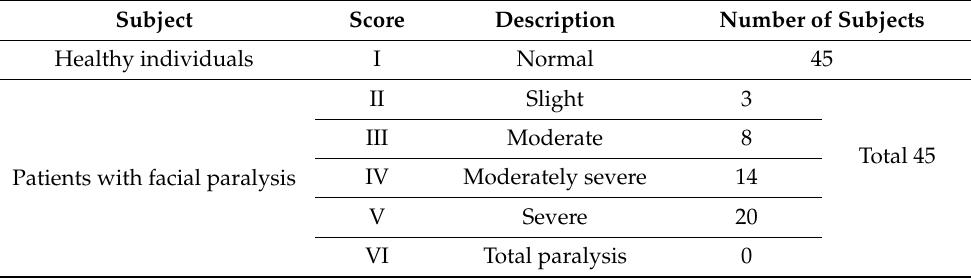
Table 1. Distribution of the House-Brackmann scores in the